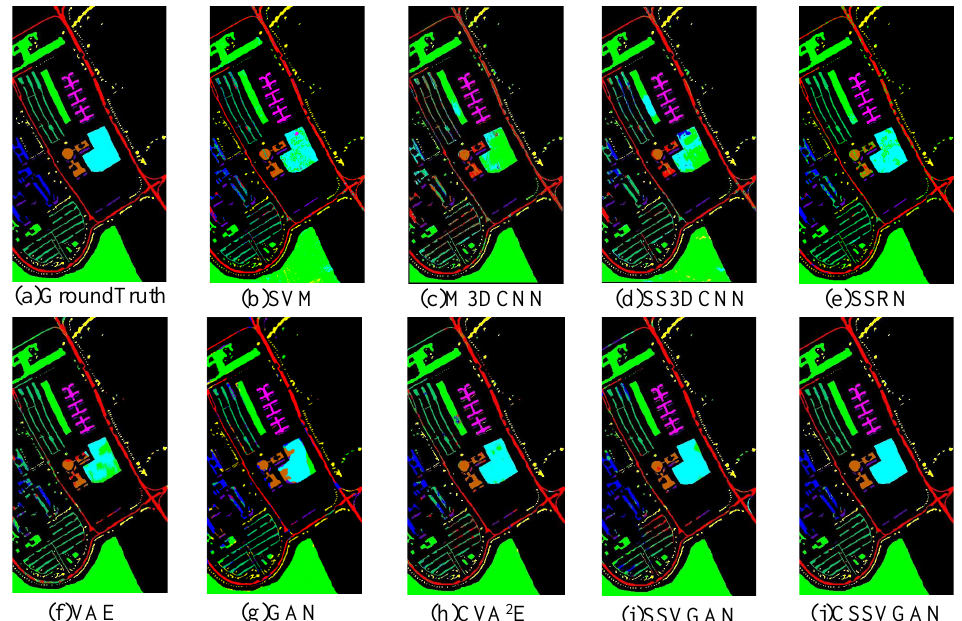
Figure 11. Classification maps for the PU dataset with 1% labeled training samples: ( a ) GroungTruth ( b ) SVM ( c ) M3DCNN ( d ) SS3DCNN ( e ) SSRN ( f ) VAE ( g ) GAN ( h ) CVA 2 E ( i ) SSVGAN ( j )